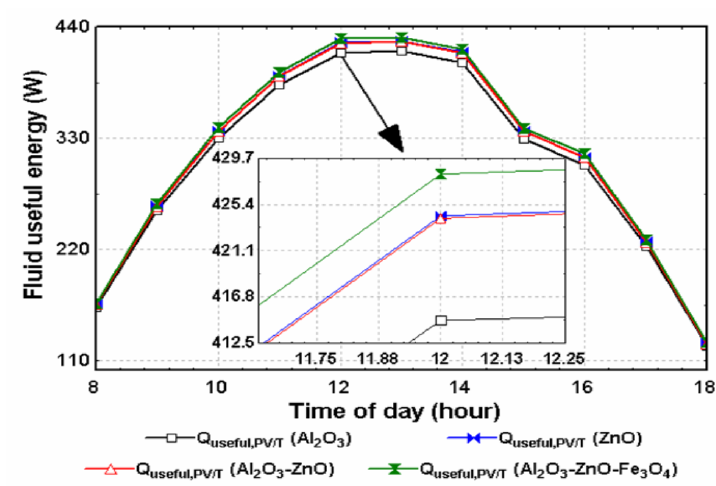
Figure 11. Numerical result of fluid useful energy of